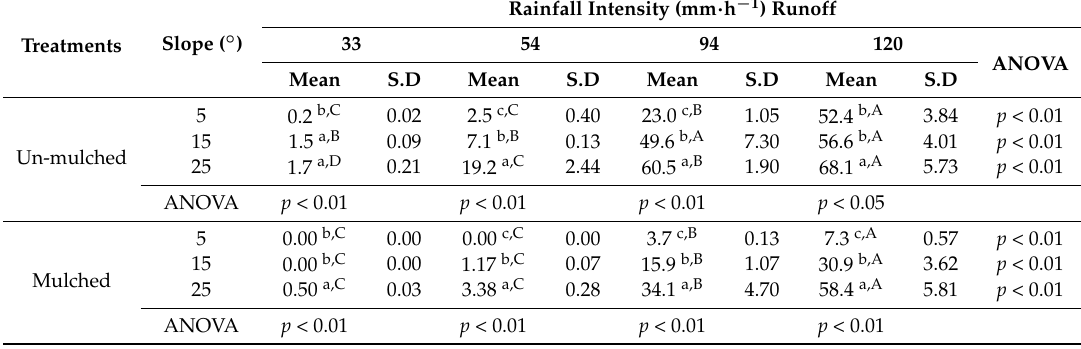
Table 1. Mean runoff loss (mm · m − 2 ) values under various rainfall intensities and slopes in un-mulched and mulched